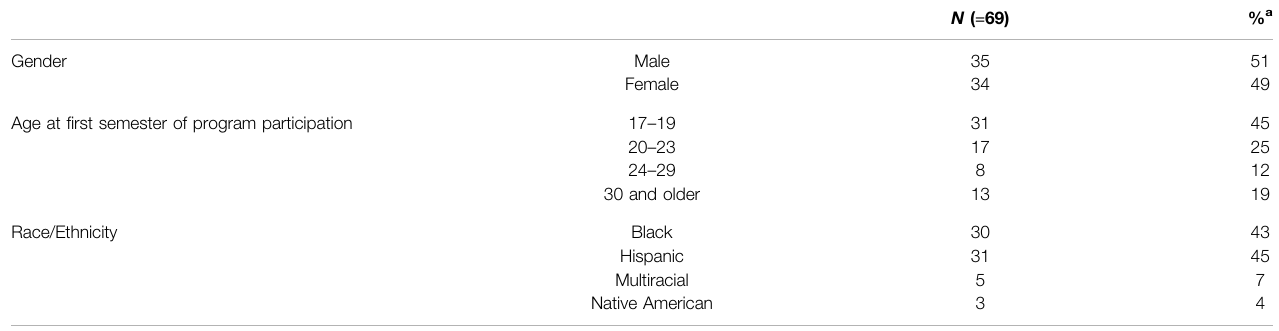
TABLE 2 | Inspire Scholars Program participant demographic information in their fi rst term in the program.